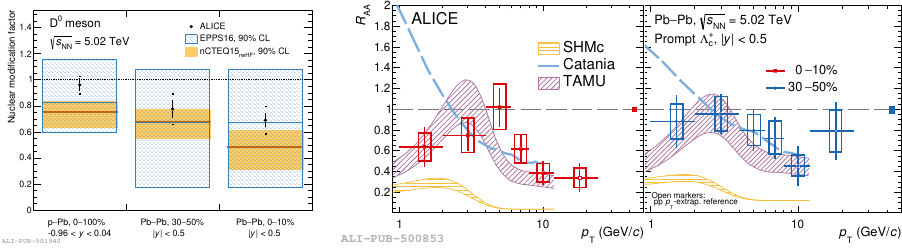
Figure 1. Left: p T -integrated R AA for D 0 mesons [1]. Right: R AA of Λ c compared with models